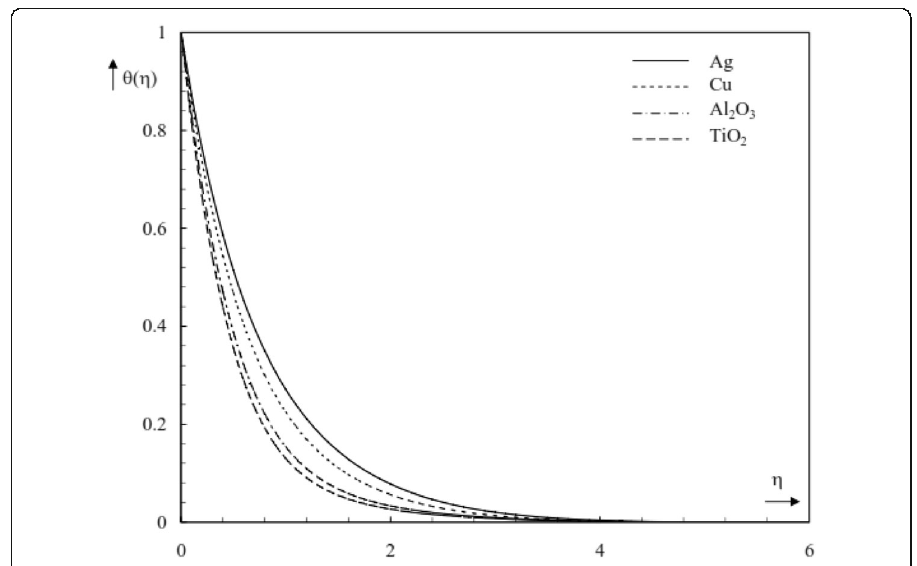
Fig. 4 Temperature profile for different types of nanofluids for S = M = f w = 0.1 and A = B = λ =